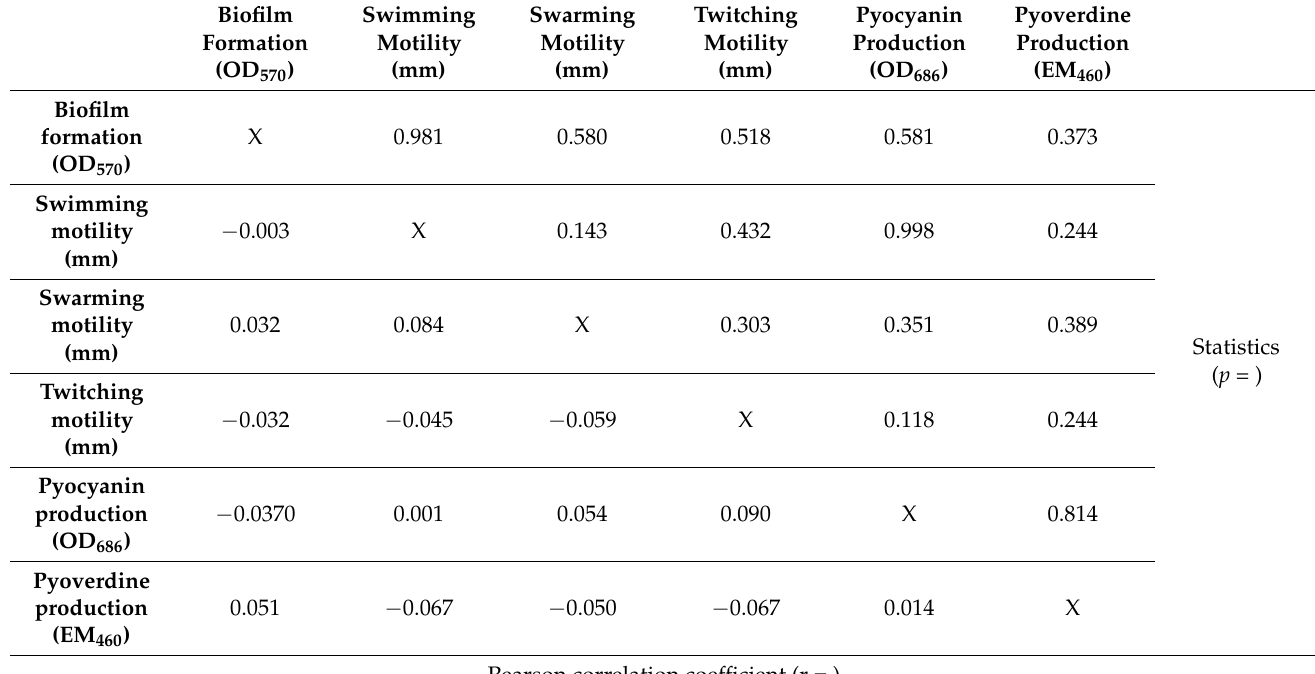
Table 4. Correlation matrix regarding the phenotypic expression of biofilm formation and other virulence factors among tested P. aeruginosa